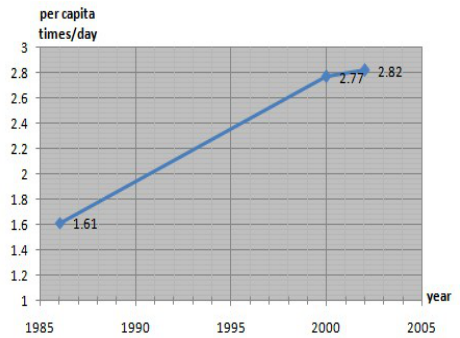
Fig. 1. Number of trips per capita per day in Beijing (1986, 2000, 2002)